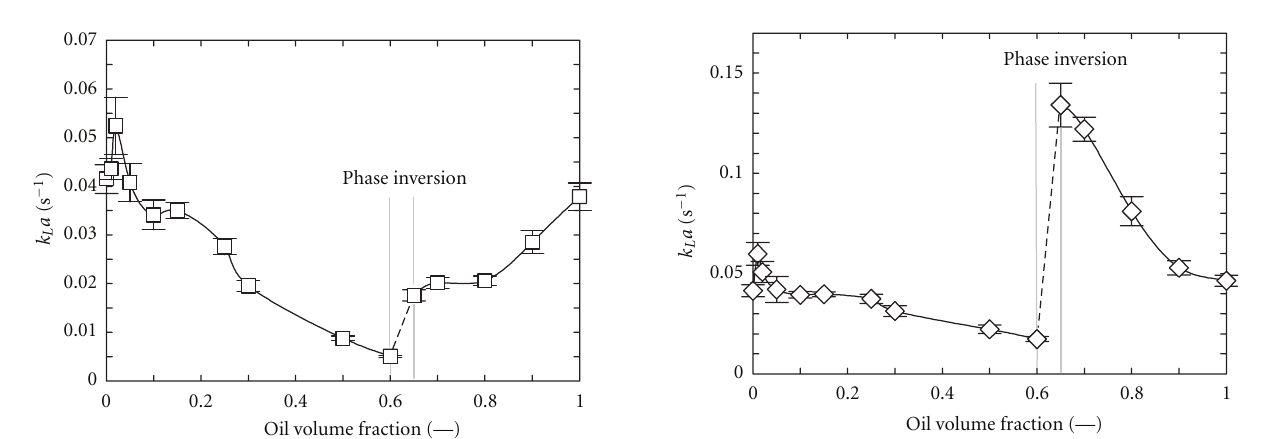
Figure 5: E ff ect of n-hexadecane volume fraction on k L a . Figure 6: E